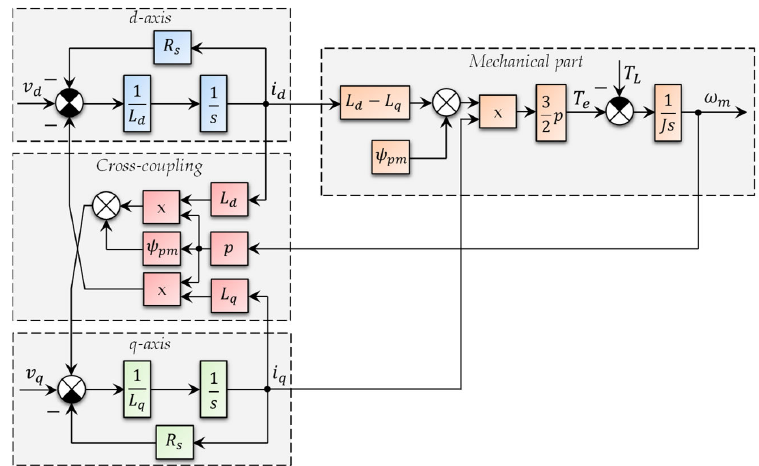
Figure 2. Block diagram of the PMSM in rotational reference frame dq .